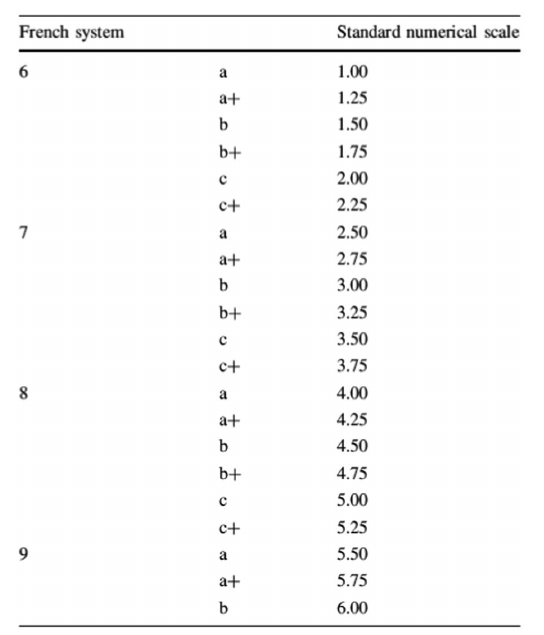
FIGURE 1 Conversion scale for standardizing climbing performance (Watts et al.,